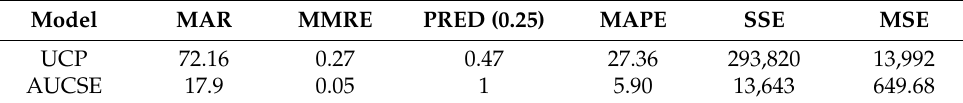
Table 2. Comparison of UCP and AUCSE.